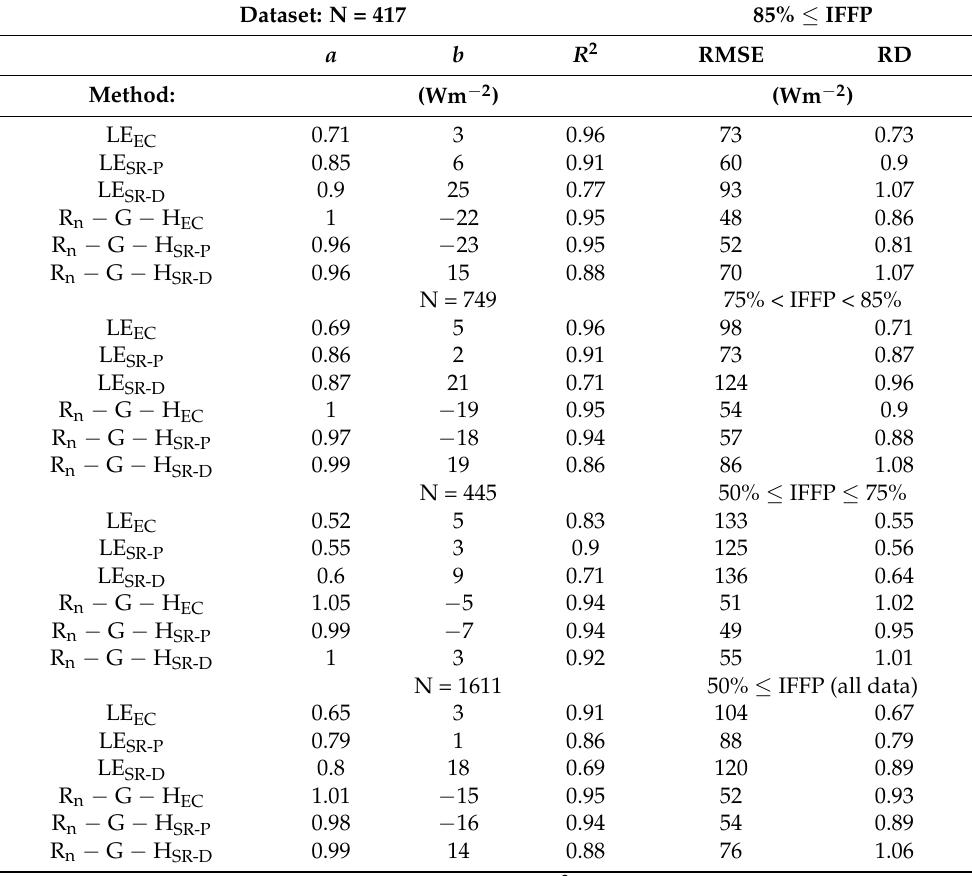
Table 2. Comparison of the latent heat flux estimates versus the reference (lysimeter).